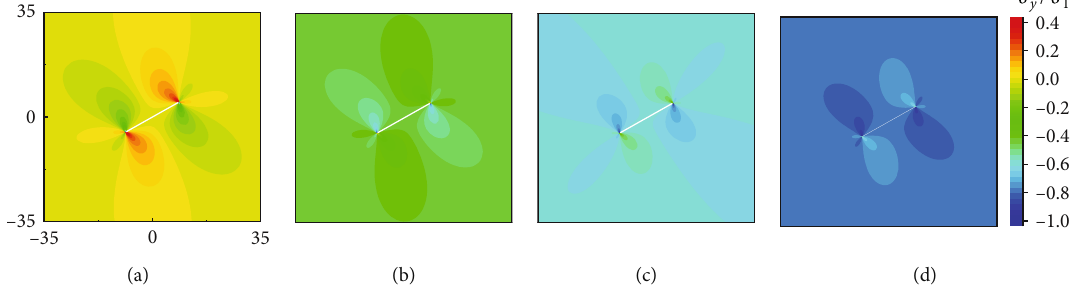
Figure 17: The contour plot of normalized σ